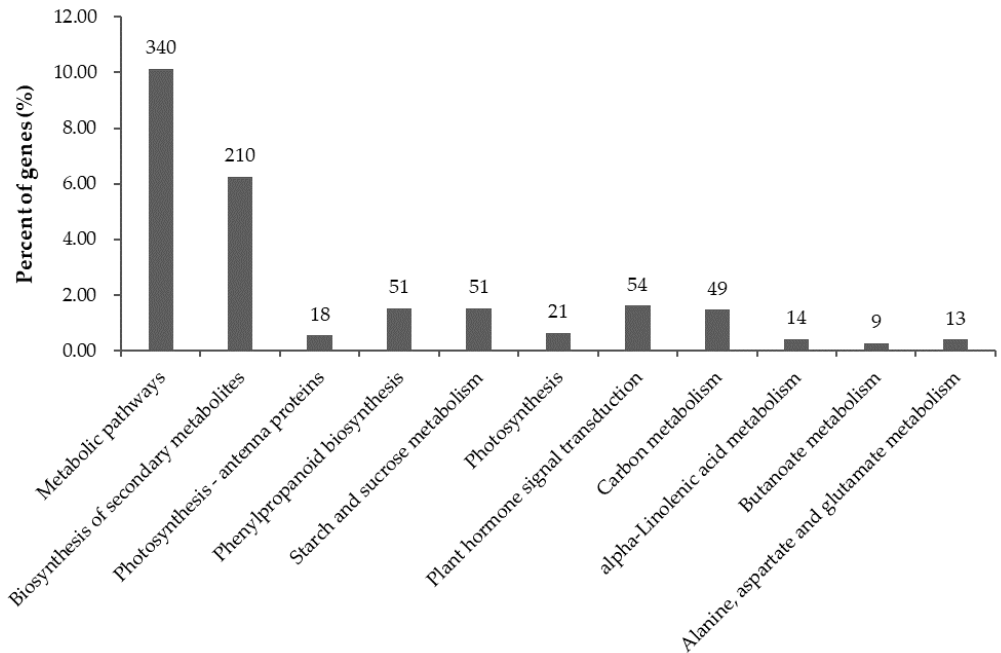
Figure 6. The distribution of pathways of differentially expressed genes (DEGs) annotated in the Kyoto Encyclopedia of Genes and Genomes (KEGG) data library. X -axis, the name of 11 significant pathways in KEGG; Y -axis, percentage of DEGs annotated in the pathway.